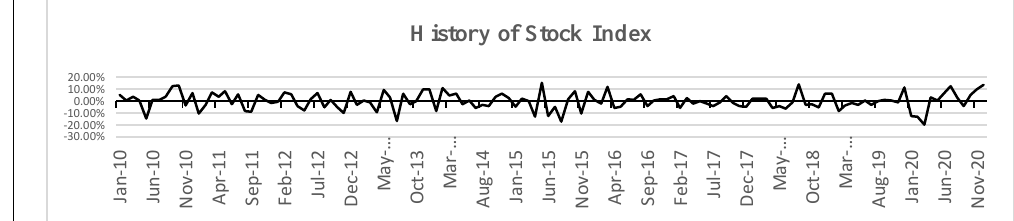
Figure 1. Graphic of the Stock Index of Agriculture in Indonesia ( *Source :